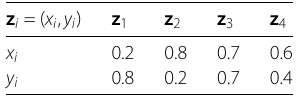
Table 1 The locations z i of the considered obstacles Q z